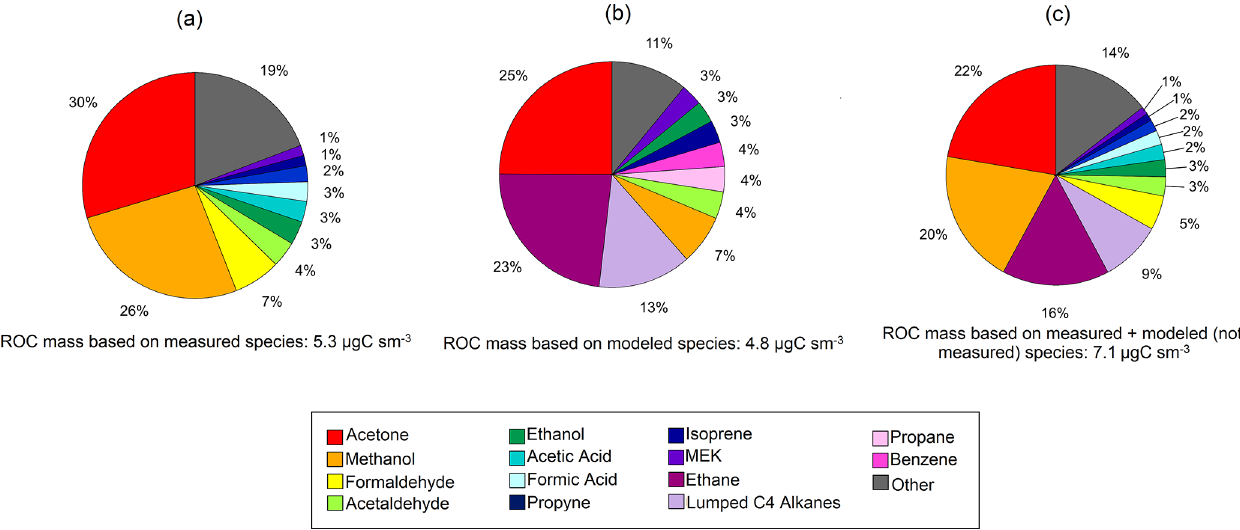
Figure 8. Pie charts of reactive organic carbon (ROC) for observed (a) and simulated (b) species at Toolik Field Station (TFS). Also shown is our best guess of ROC at TFS with ethane and the other higher alkanes (Lumped C 4 alkanes) estimated by the model (c) . The relative contribution of individual compounds to ROC mass is calculated based on median values during the